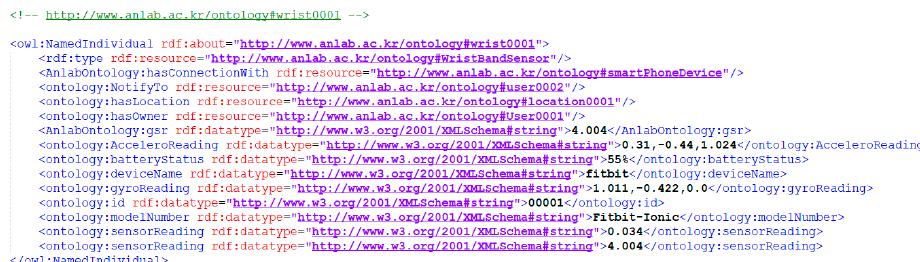
Figure 7. Semantic representation of wrist wearable device VO.